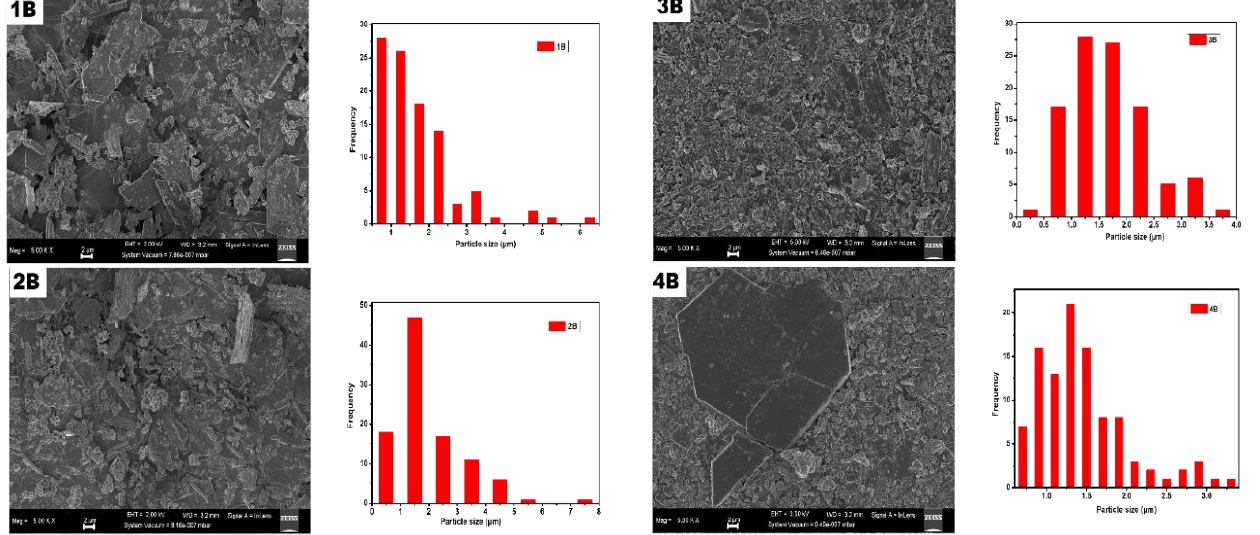
Figure 15. Scanning electron microscope (SEM) pictures and their particle size distribution histogram of Nanoparticles samples produced from AMD.